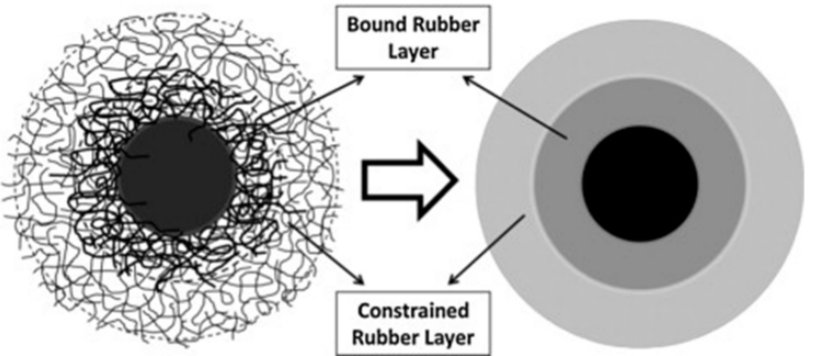
Figure 4. Schematic representation of interfacial structure between filler and polymer (bold lines mean adsorbed chains)